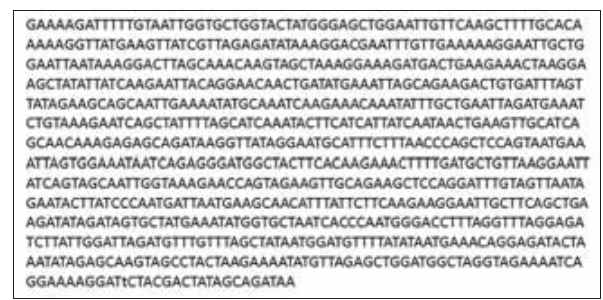
Figure-4: Nucleotide sequence of nad-bhbd